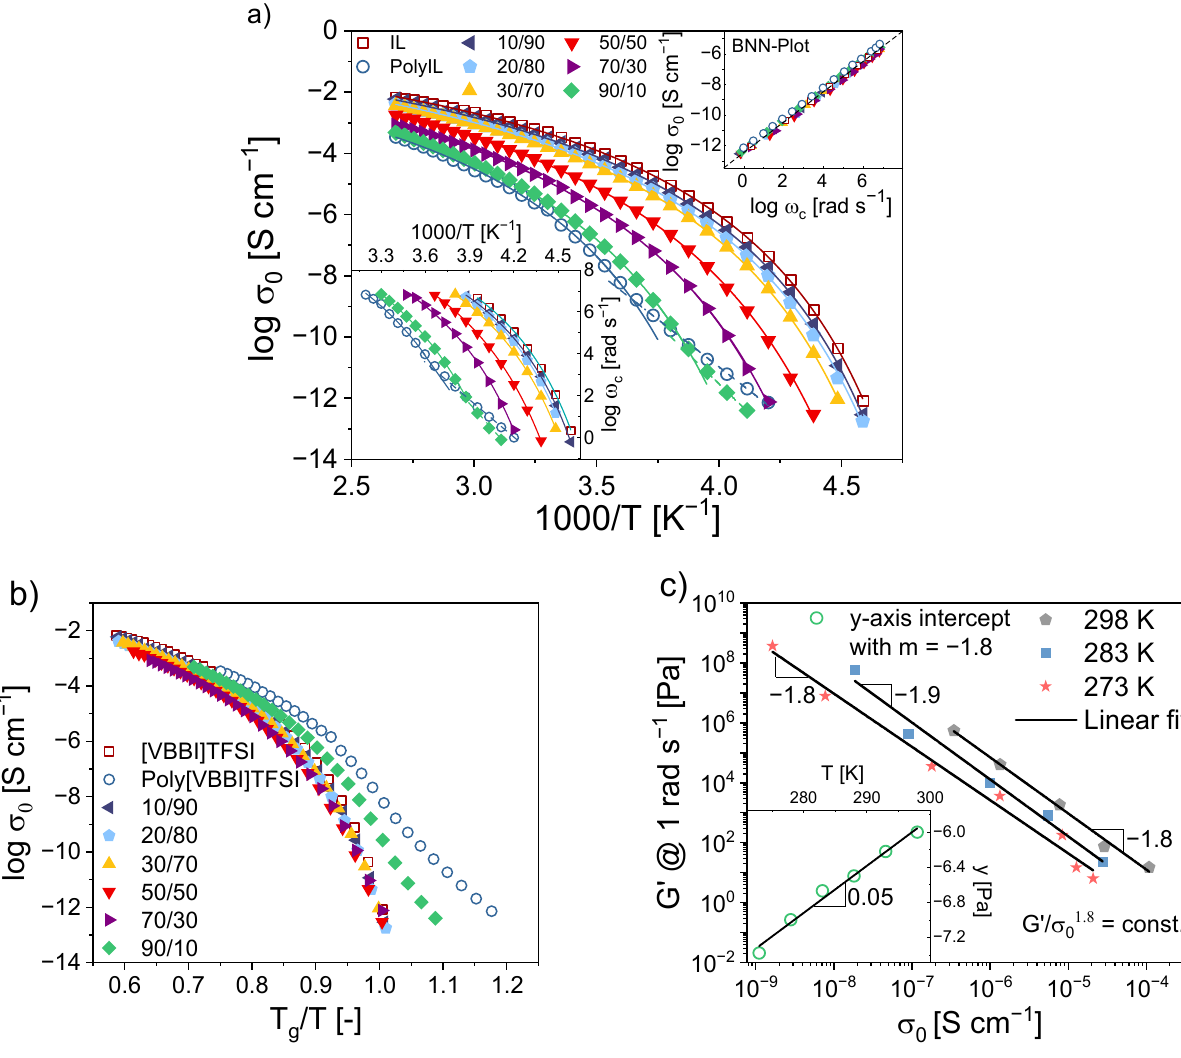
Figure 3. ( a ) Ionic conductivity ( σ 0 ) as a function of the inverse temperature including VFT and Arrhenius fits (solid and dashed lines, respectively). The inset on the upper right shows σ 0 versus the rate of charge transport ( ω c ) . The Barton–Nakajima–Namikawa relationship (BNN) indicates that the mechanism of the charge transport is the same for all samples. The inset on the lower left displays the temperature dependence of ω c , which is the same as for σ 0 . ( b ) σ 0 as a function of T g / T to suppress the influence of the different T g of the samples. ( c ) The correlation between the storage modulus ( G (cid:48) ) at 1 rad s − 1 and σ 0 at three temperatures is found to be linear to a good approximation. The inset in ( c ) shows the temperature dependence of the y -axis intersection of the linear fits from ( b ) using a slope of 1.8, which also shows a linear dependence on T